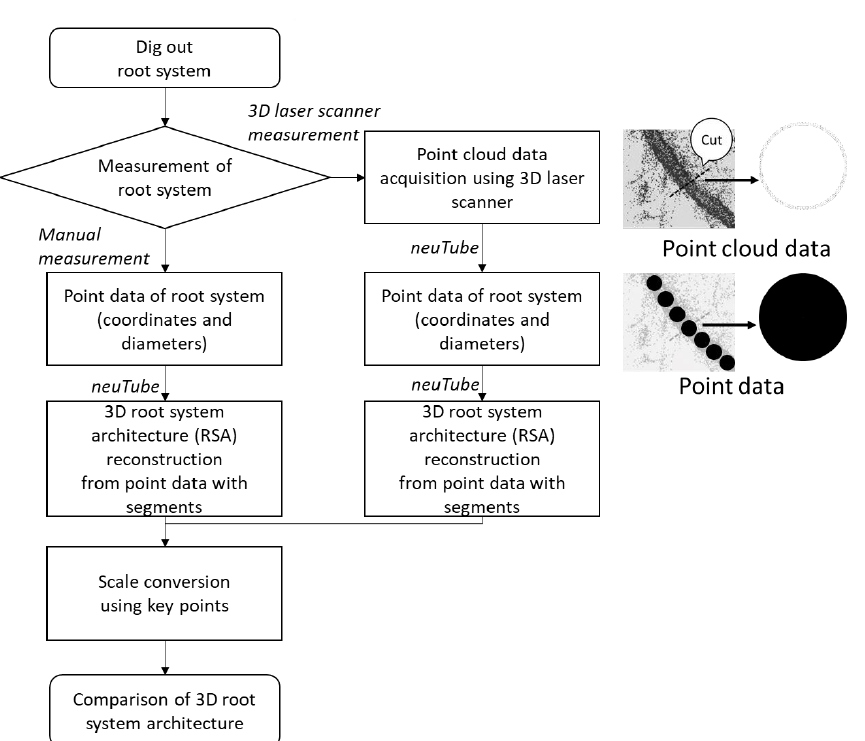
Figure 2. Acquisition of point cloud data and root point data and reconstruction of root system architecture (RSA).